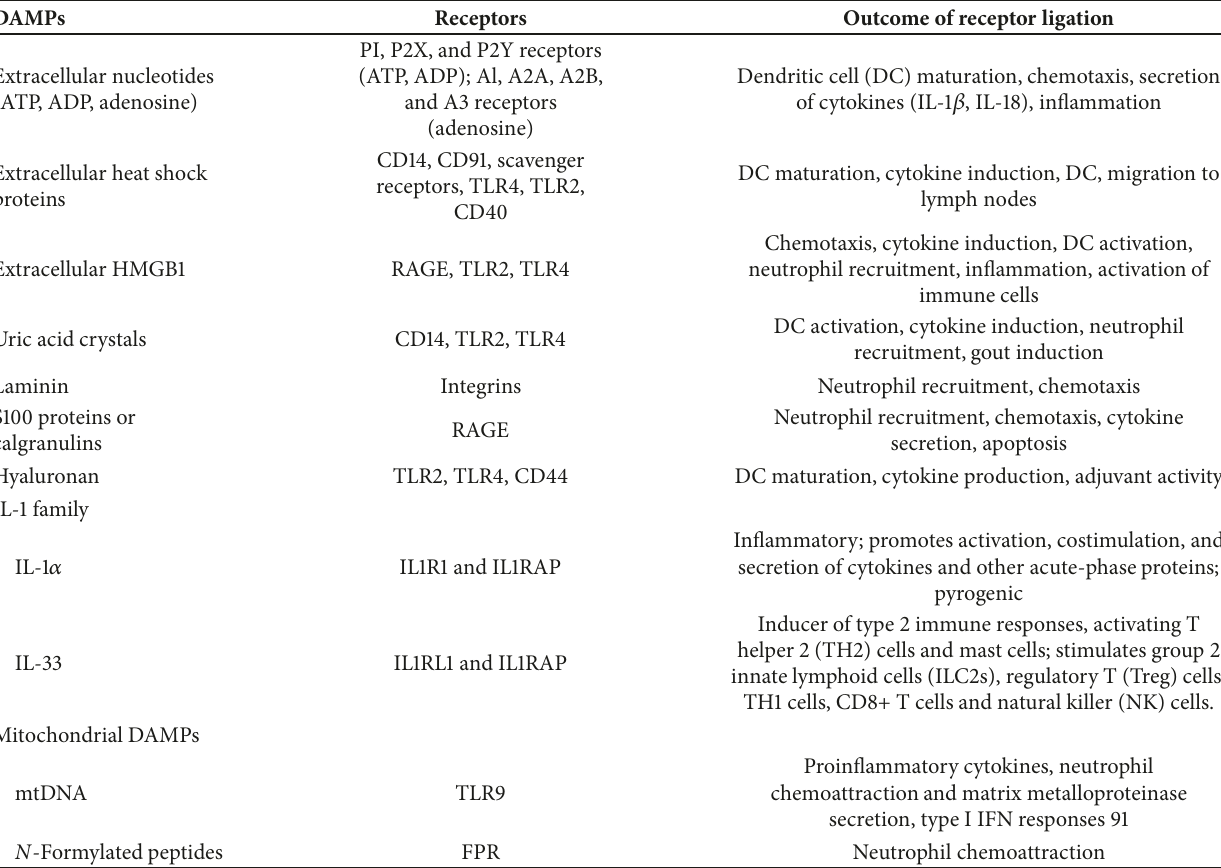
Table 2: Examples of well-characterized DAMPs (danger signals or